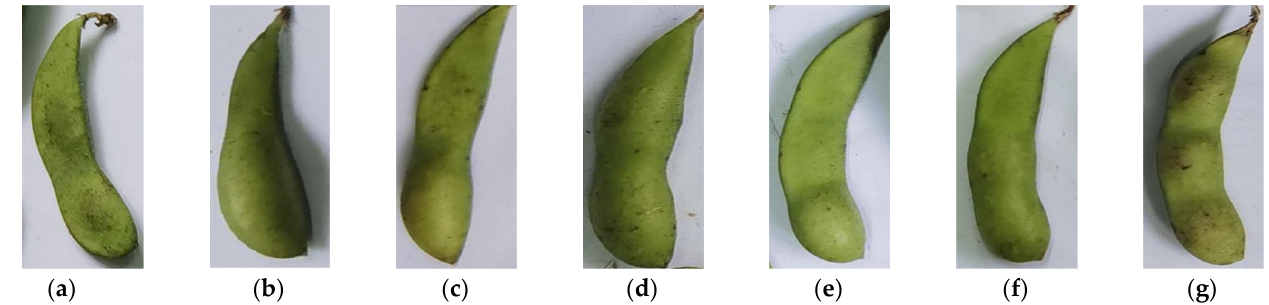
Figure 4. Samples of different pods. ( a ) Empty, ( b ) 1B, ( c ) 1B-1E, ( d ) 2B, ( e ) 1B-2E, ( f ) 2B-1E, ( g ) 3B. Table 2. Distribution of each class of pods in different datasets.